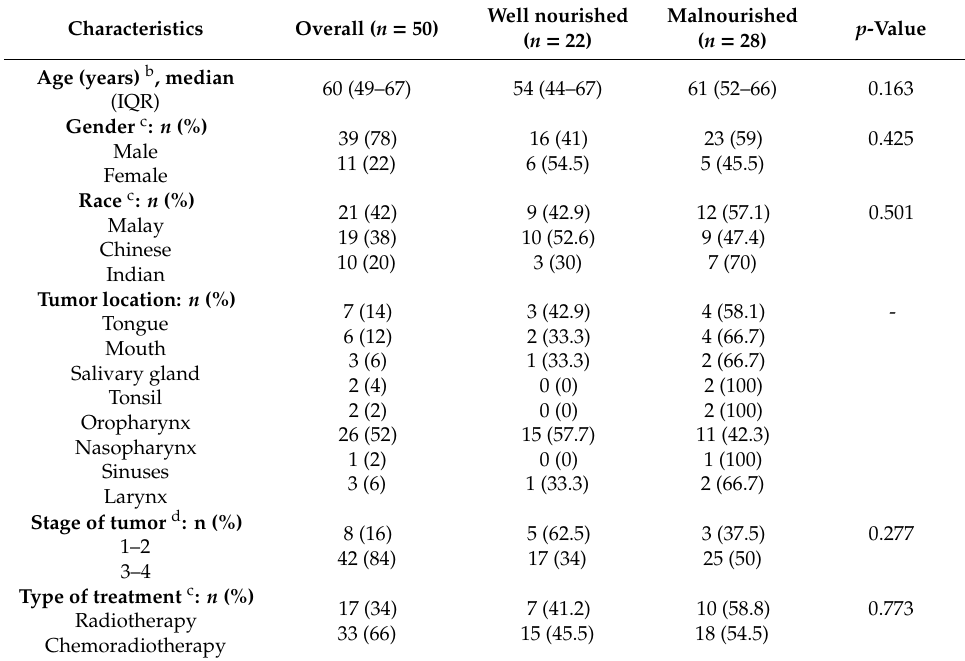
Figure 1 . Flow diagram of the protocol. Figure 1. Flow diagram of the protocol. Table 1. Baseline patient